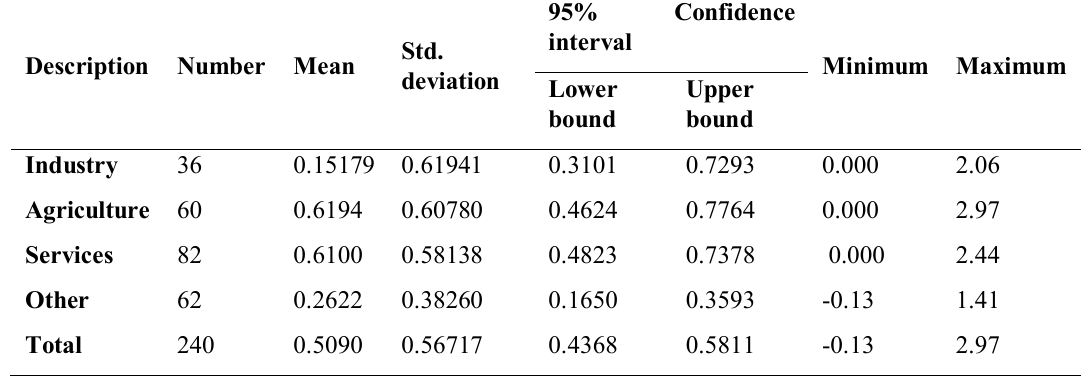
Table 15–Descriptive Statistics relating to the ROA (various sectors at high quartile of investments)